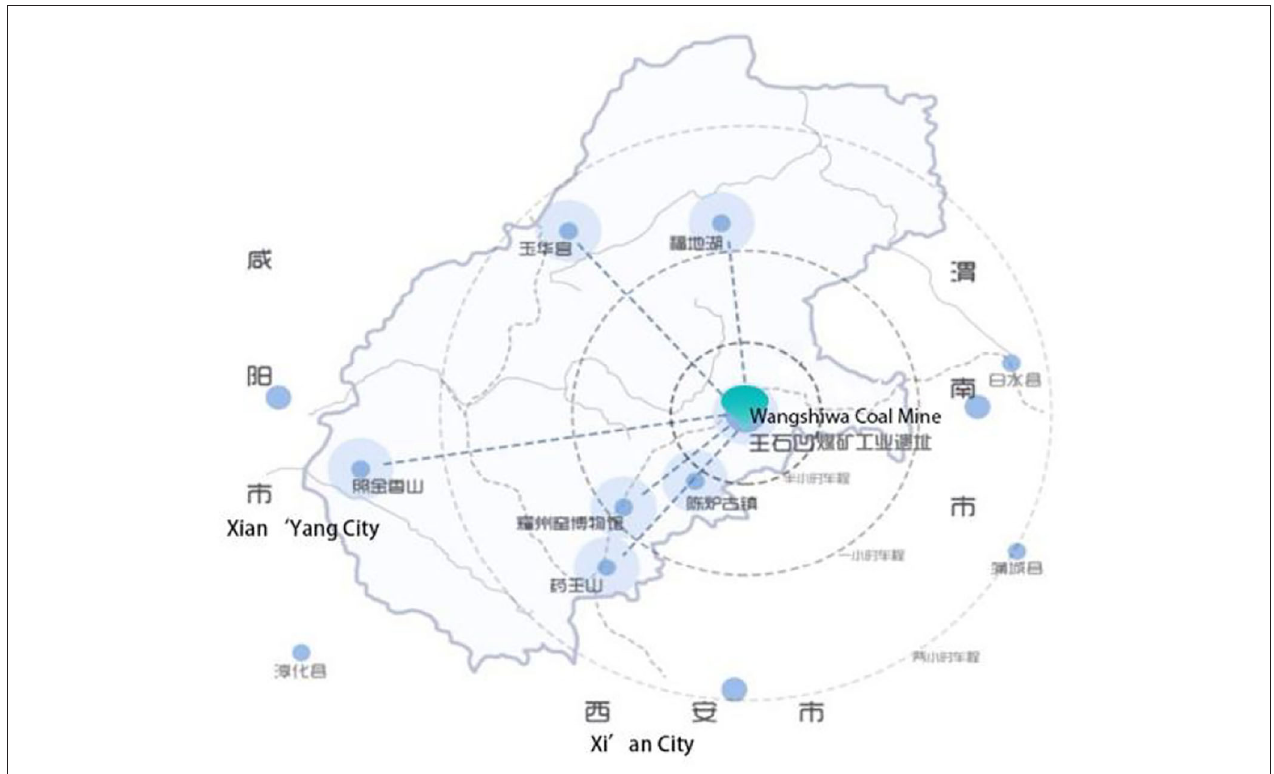
FIGURE 1 | Location map of Wangshiwa Coal